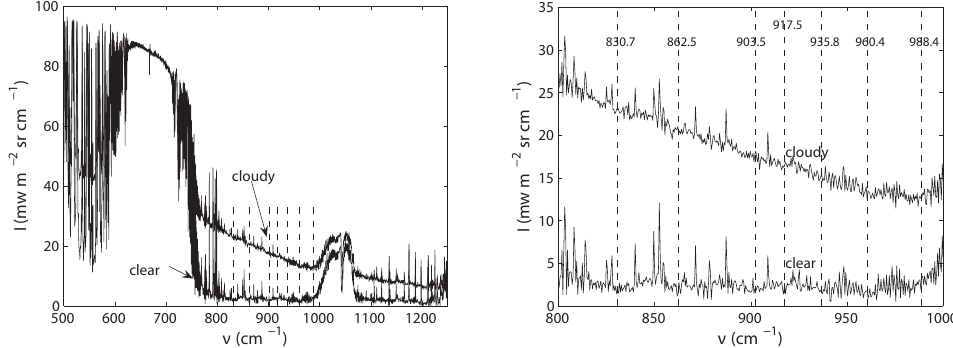
Fig. 2. Selected micro-windows in the atmospheric window, at which atmospheric gases absorption is particularly small. The upper and lower spectral radiation are for cloudy and clear conditions, respectively, measured at ARM NSA-AAO on 7 May 2001.